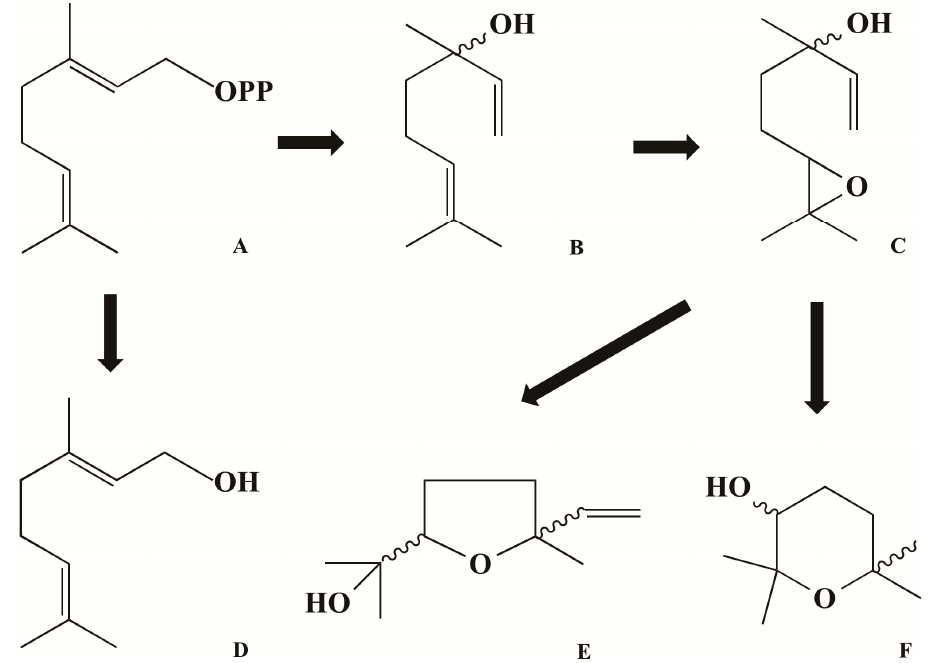
Figure 2. Formation of fatty acid-derived volatiles: ( A ) geranyl pyrophosphate; ( B ) linalool; ( C ) linalool-6,7-epoxide; ( D ) geraniol; ( E ) linalool oxide (puranoid); ( F ) linalool oxide (furanoid).